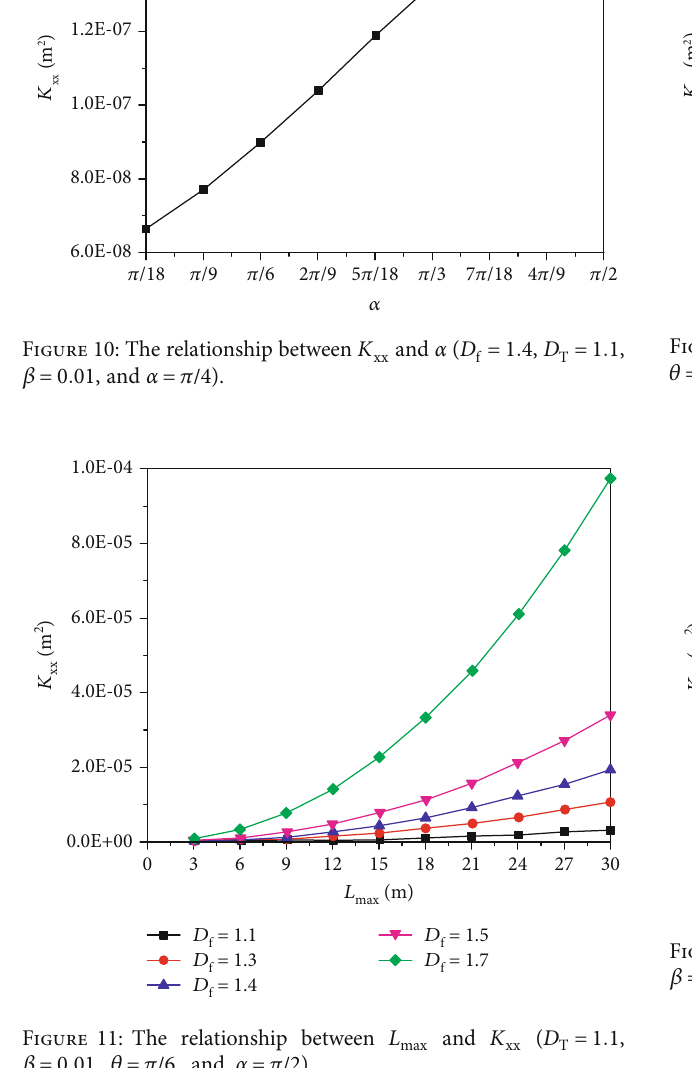
and K ( D = 1 : 1 , max xx T